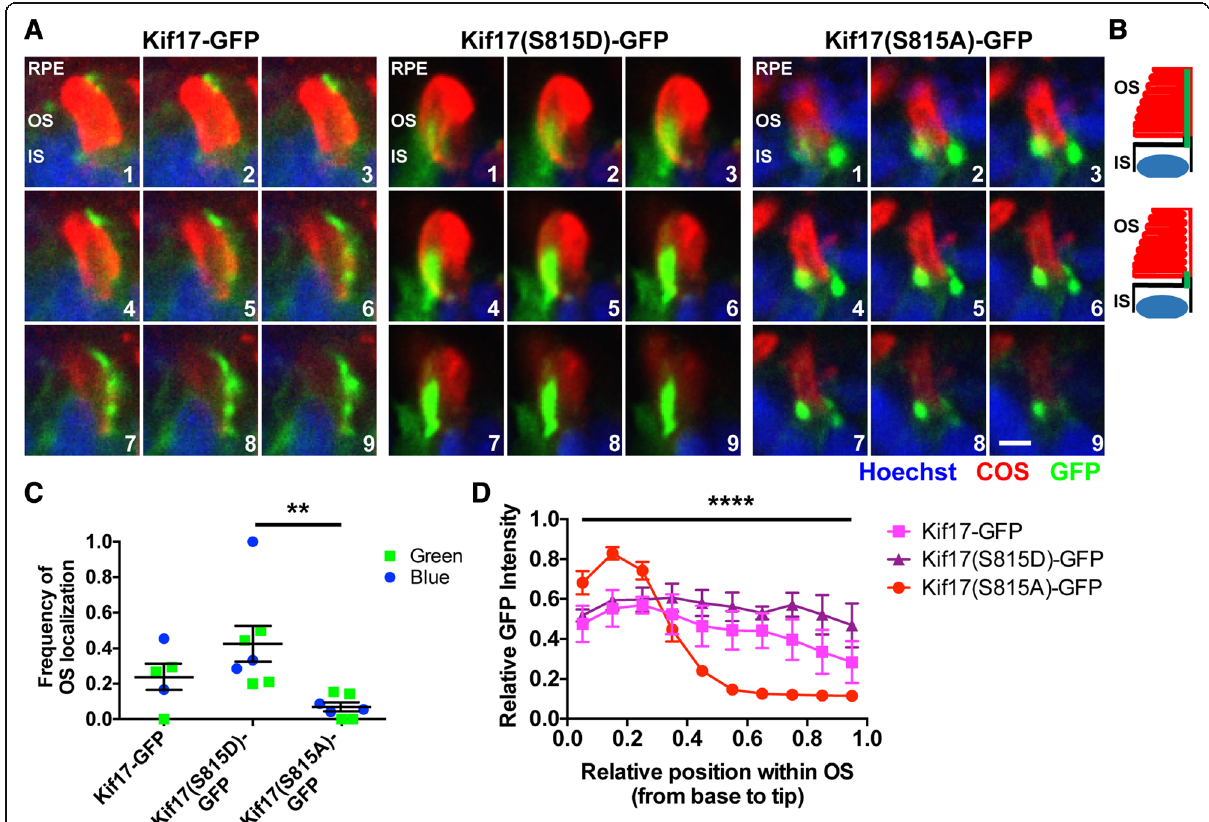
Fig. 2 Phospho-mutations of S815 regulate photoreceptor OS localization of Kif17. a 5 dpf larvae previously injected at the one cell stage with one of three different transgenic constructs under control of the TaCP promoter for expression in cone photoreceptors: Kif17-GFP (left), phospho-mimetic Kif17(S815D)-GFP (middle), and phospho-deficient Kif17(S815A)-GFP (right) were stained with Hoechst (blue) to label nuclei and blue cone opsin (red) to label cone OS (COS). A z-series of confocal images was taken with 0.2 μ m steps through the depth of the photoreceptor OS. Shown are montages of sequential images in the z-series revealing that Kif17(S815D)-GFP exhibits significant accumulation in the OS while Kif17(S815A)-GFP accumulates at the base of the OS. Note that in cone photoreceptors, the ciliary axoneme extends along the side of the opsin-containing discs. Scale bar is 1 μ m. b Models depicting structure of the photoreceptor OS imaged in Fig. 2a. There appears to be two subsets of GFP localization: GFP localizing along the length of the OS (top) and GFP accumulating at the base of the OS (bottom). c Quantification of the frequency of OS accumulation of Kif17-GFP ( n = 5 total injected larvae: 3 stained for green opsin, 2 stained for blue opsin; 60 cells), Kif17(S815D)-GFP ( n = 7: 4 green, 3 blue; 62 cells), and Kif17(S815A)-GFP ( n = 7: 4 green, 3 blue; 126 cells) when co-labeled with either green opsin (square) or blue opsin (circle). d Line intensity analysis of the GFP signal for Kif17-GFP (pink line, n = 5 total injected larvae: 3 stained for green opsin, 2 stained for blue opsin; 17 cells), Kif17(S815D)-GFP (purple line, n = 5: 3 green, 2 blue; 17 cells), and Kif17(S815A)- GFP (red line, n = 5: 3 green, 2 blue; 25 cells). Two-way ANOVA was performed to determine significance in the different interaction between GFP signal intensity pattern and transgene ( p < 0.0001,